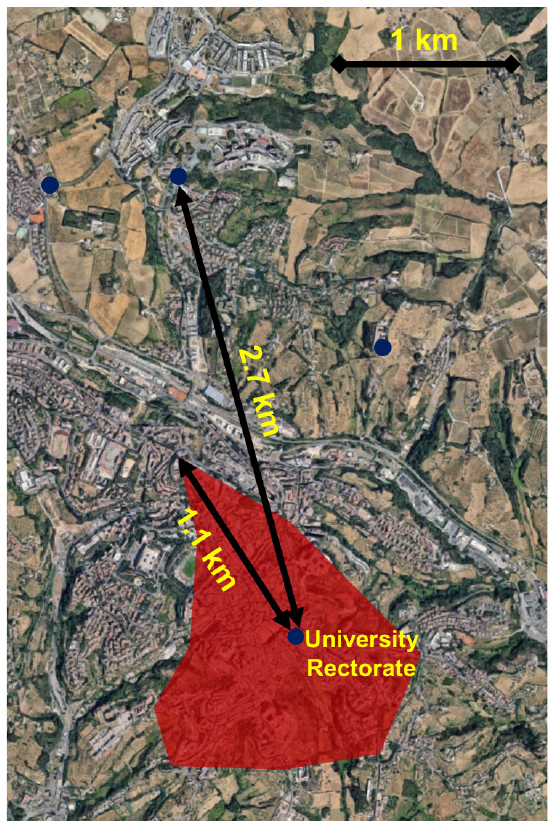
Figure 9. Map of the area covered by the LoRa network. Blue dots indicate the more distant line-of-sight